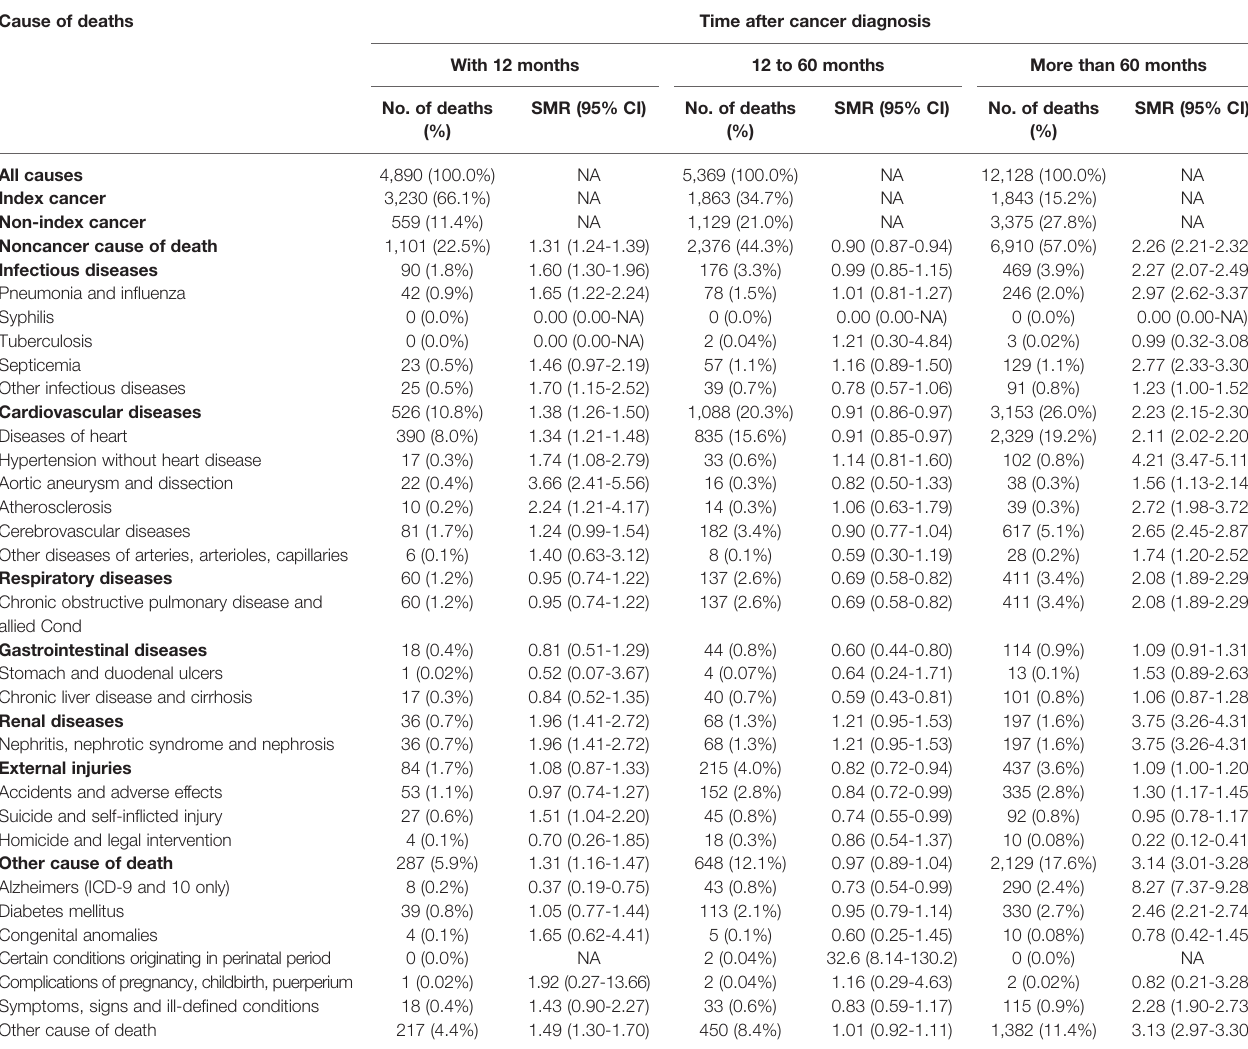
TABLE 3 | Cause of death among patients with thyroid cancer by time after